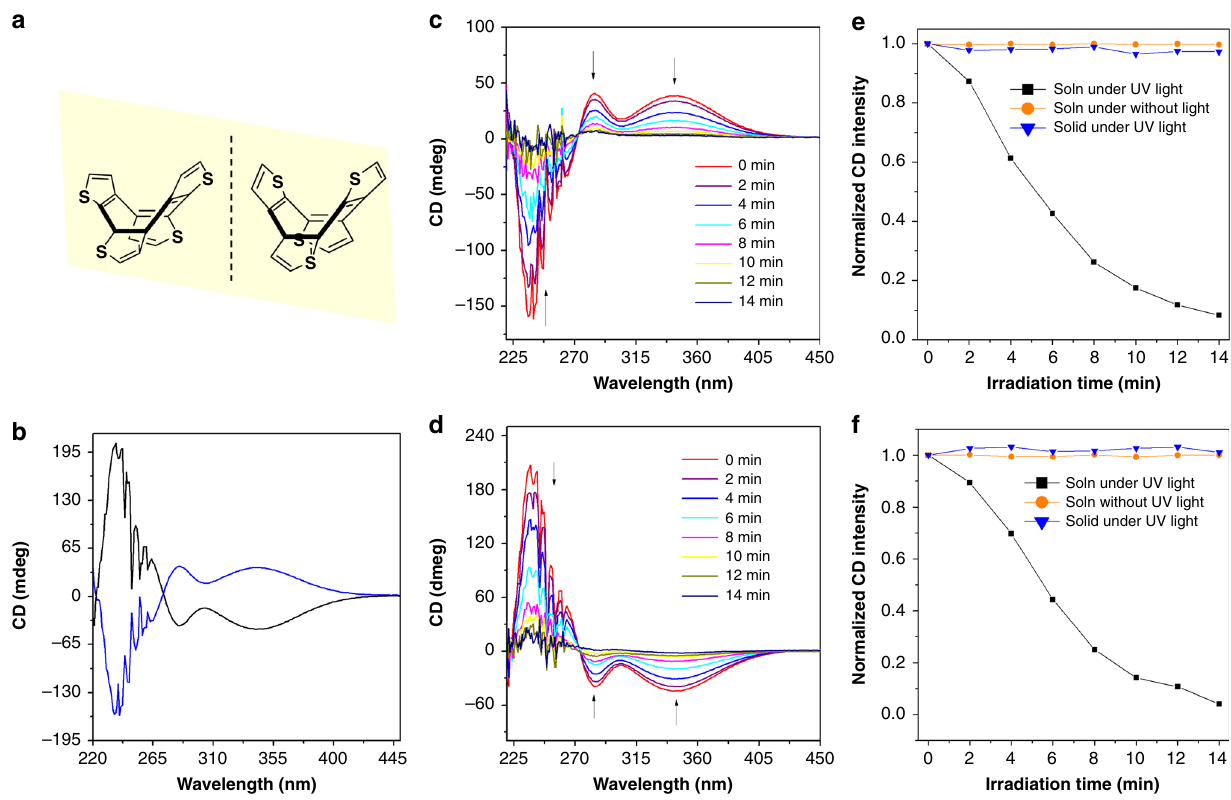
Fig. 5 Circular dichroism spectroscopy. a The two enantiomers of COTh. b CD spectra of the two enantiomers of COTh in freshly distilled THF solution at 298 k. c , d Time-dependent CD spectral change pro fi les of the two enantiomers of COTh in freshly distilled THF solution under UV lamp irradiation at 298 k. e , f Time-dependent CD spectral change pro fi les of the two enantiomers of COTh in freshly distilled THF solution with UV lamp irradiation (black square line) and without UV lamp irradiation (orange circle line), and in the solid state with UV lamp irradiation (blue triangle line) at 298 k, irradiation wavelength: 254 nm. Concentration of the two enantiomers of COTh ( − ) and COTh ( + ) are 30 and 50 μ M, respectively